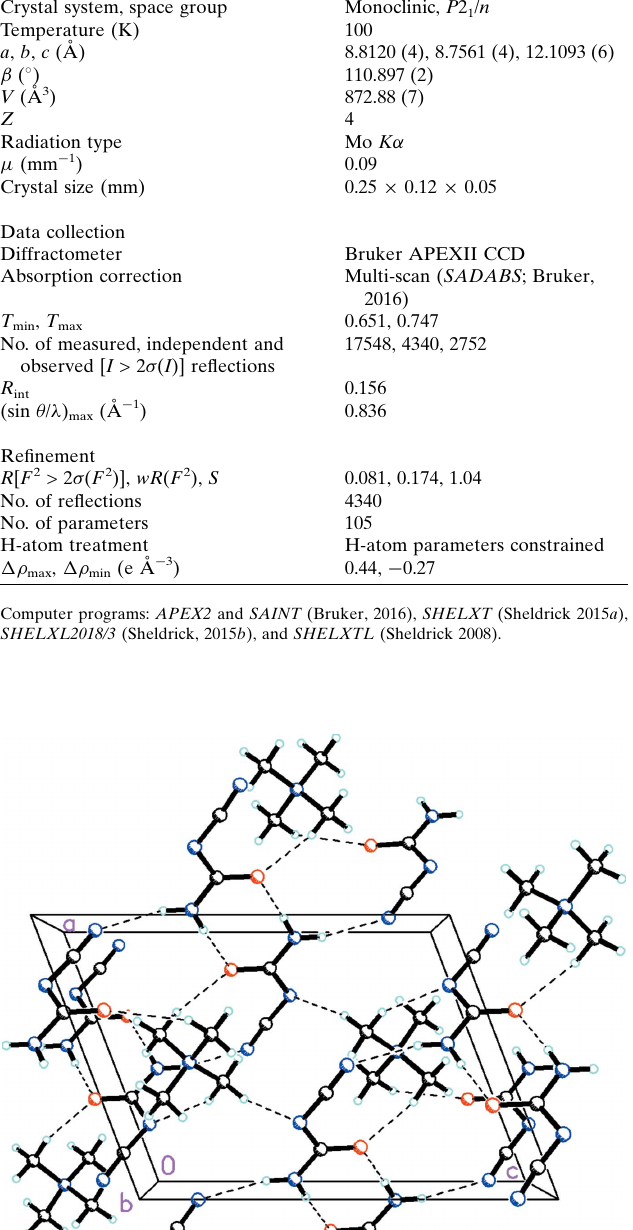
Table 3 Experimental details. Crystal data Chemical